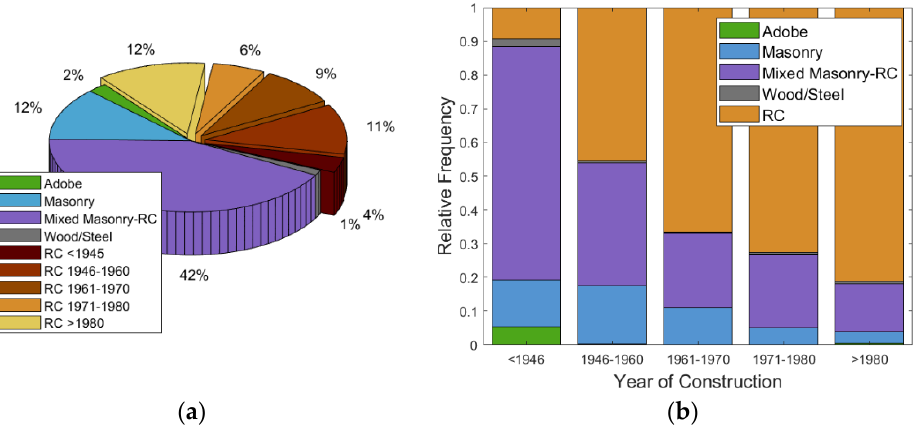
Figure 4. Distribution of Lisbon building stock based on the ( a ) building typology and ( b ) building typology and construction period.